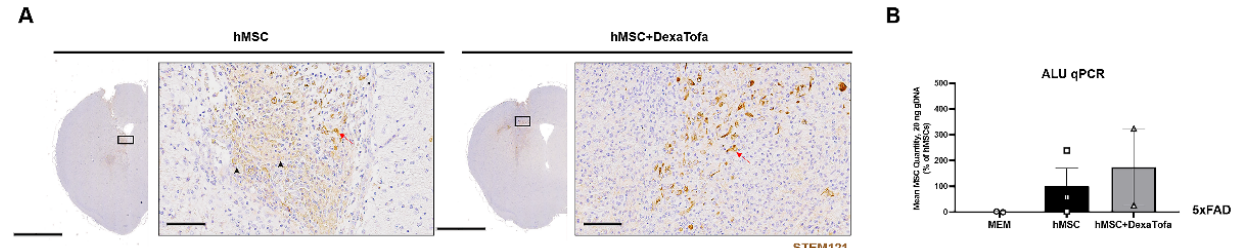
Figure 4. Quantification of residual hMSCs in the 5xFAD parenchyma. ( A ). Representative images of STEM121 positive cells (residual hMSCs). Non-specific signals are present (solid black arrowhead). Residual hMSCs (solid red arrows) were barely detected at D7 for both the hMSC and hMSC + DexaTofa groups. Scale bars: whole brain = 2 mm, magnified inset area (solid black box) = 60 µm. ( B ) ALU-qPCR was used to quantify the number of residual hMSCs present in the parenchyma for both the hMSC ( n = 3) and hMSC + DexaTofa ( n = 2) groups. Human DNA was not detected from the MEM ( n = 2) group and compared to the hMSC group, higher MSC quantity was revealed (difference is not statistically significant) from the hMSC + DexaTofa group. Values are expressed as mean ± SEM.